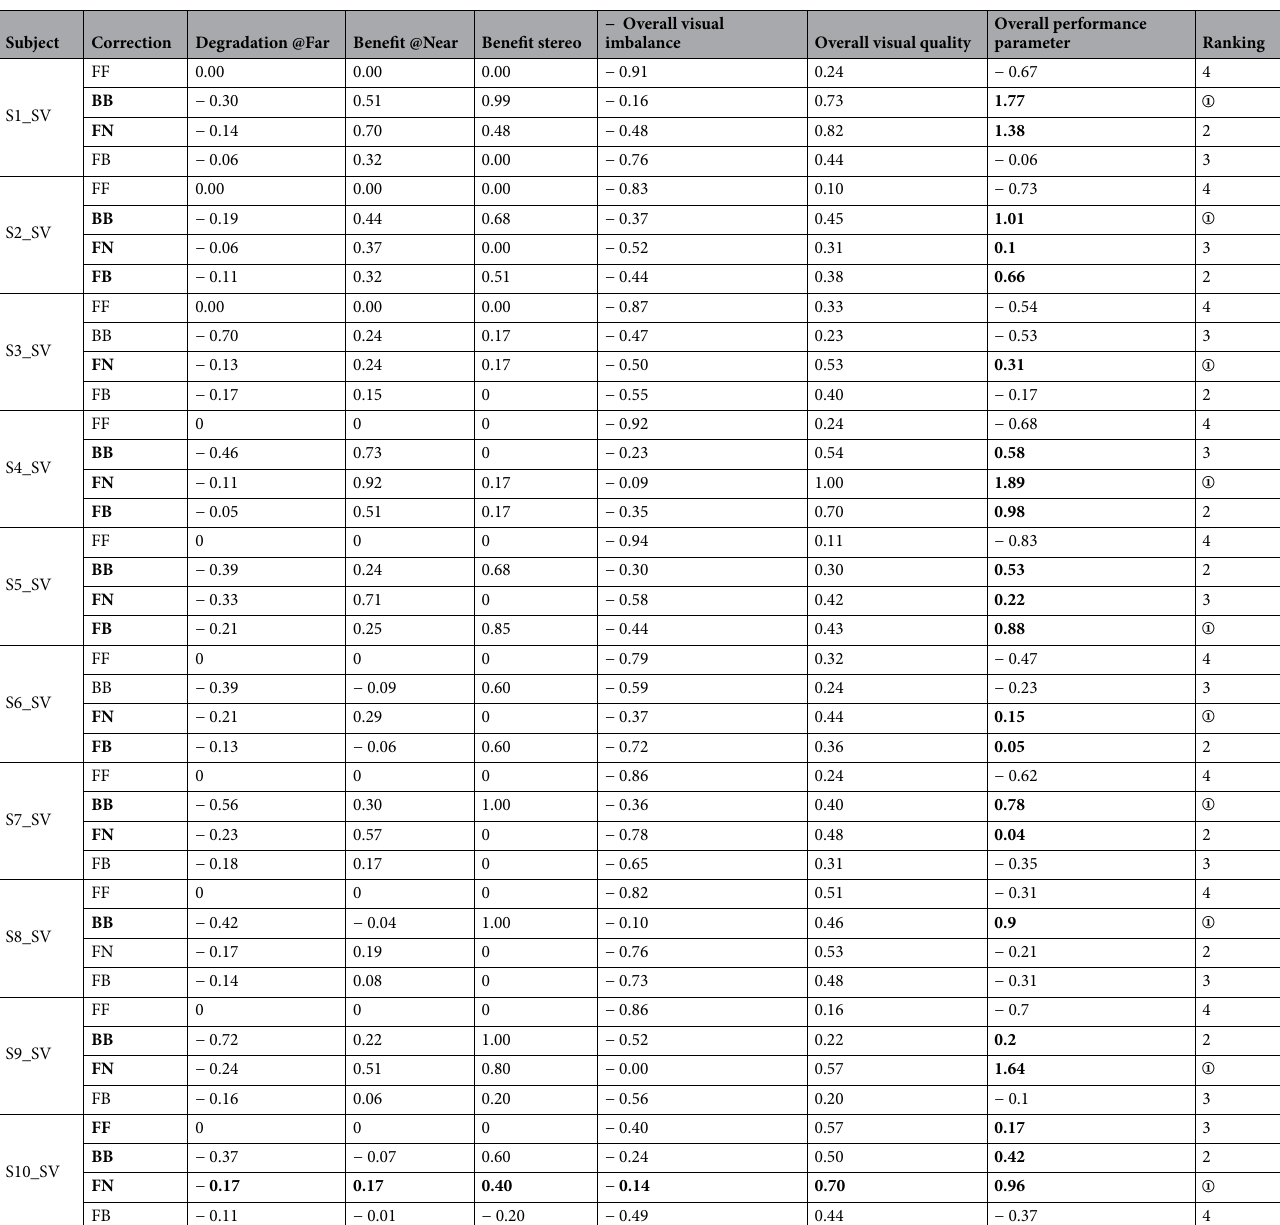
Table 2. Individual data of visual degradation at far distance, visual benefit at near distance, near stereo benefit, overall visual imbalance (negative), overall visual quality, overall performance parameter and ranking. Corrections in bold indicate acceptable overall performance. Circled correction ① indicates the highest ranking. Data correspond to measurements performed with